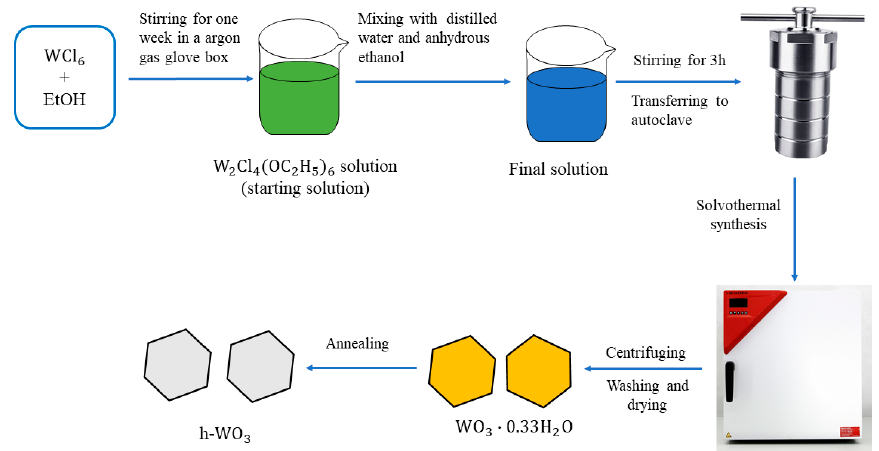
Figure 1. Schematic of solvothermal synthesis procedure. Table 1. Details of samples 1–10: list of volumes of the W 2 Cl 4 (OC 2 H 5 ) 6 solution (starting solution), the final solution, and the distilled water.